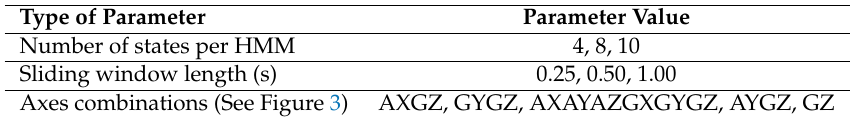
Table 1. Rough grid search for hHMM parameter